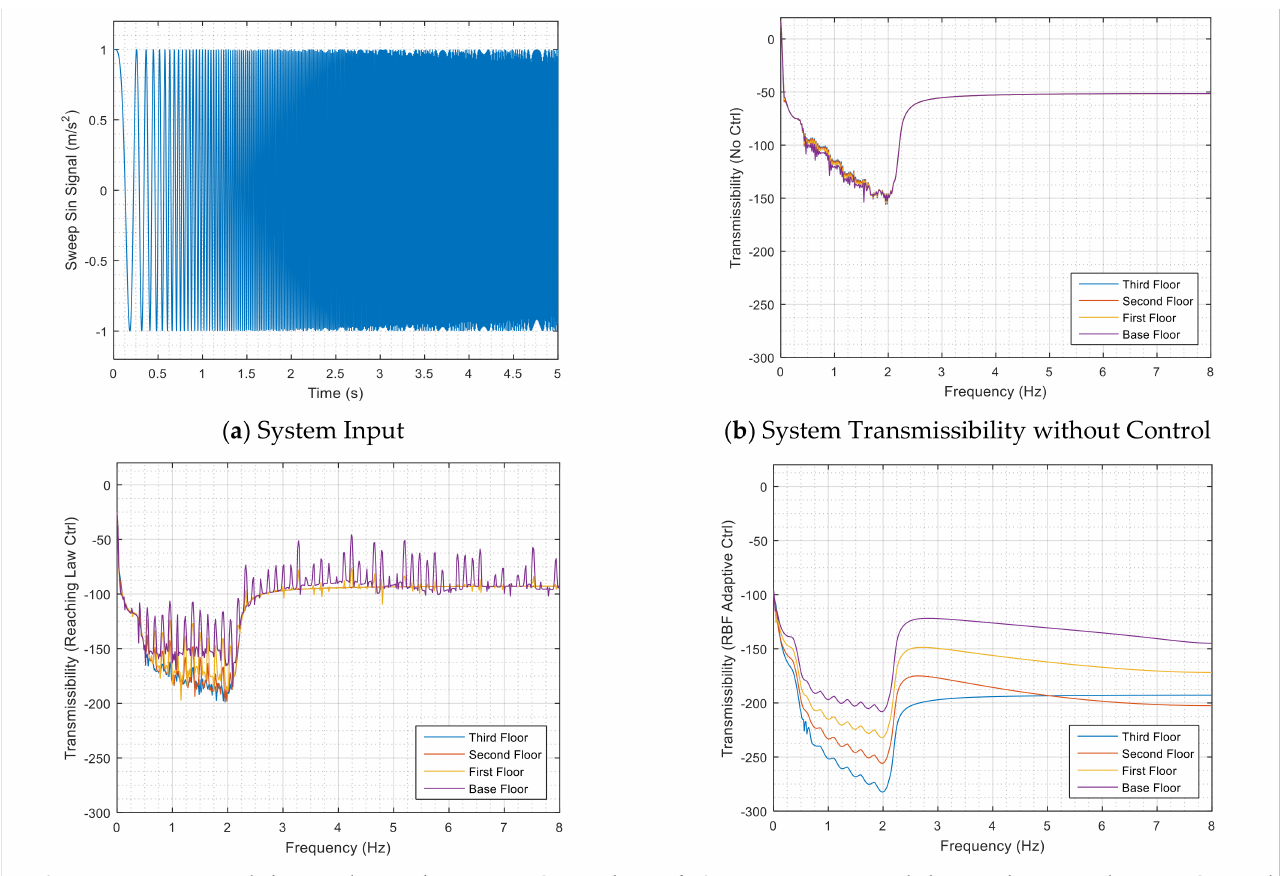
Figure 23. System Excitation and